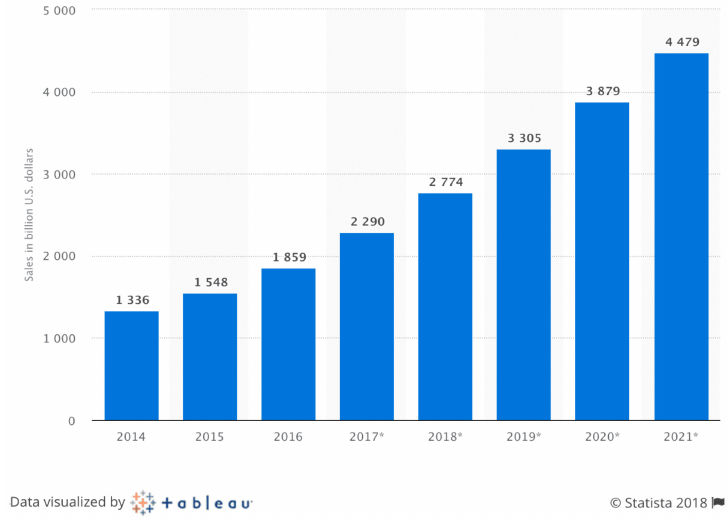
Figure 1. 2018 Statista report of global omnichannel e-commerce trend and statistic by Amasty